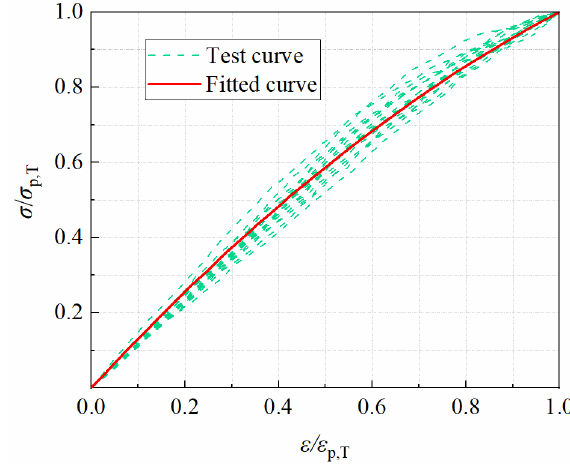
Figure 28. Comparison of test curve and fitted curve of stress–strain.